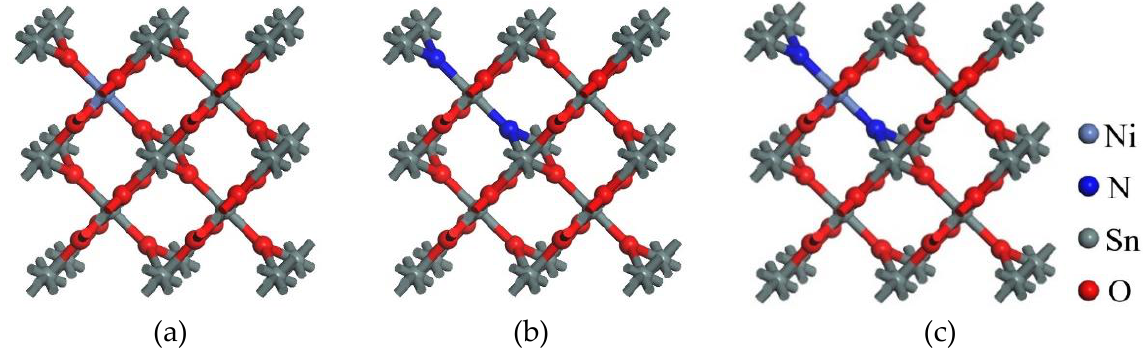
Figure 1. Doping models: ( a ). SnO 2 – Ni; ( b ). SnO 2 – N; ( c ). SnO 2 – Ni – N.